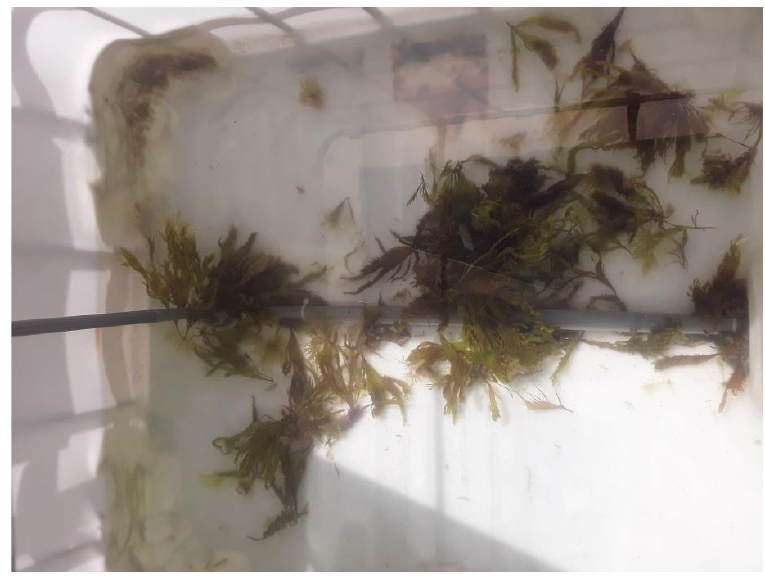
Figure 2. Cultivation of the marine macroalgae Calliblepharis jubata in an external environment (out- door).